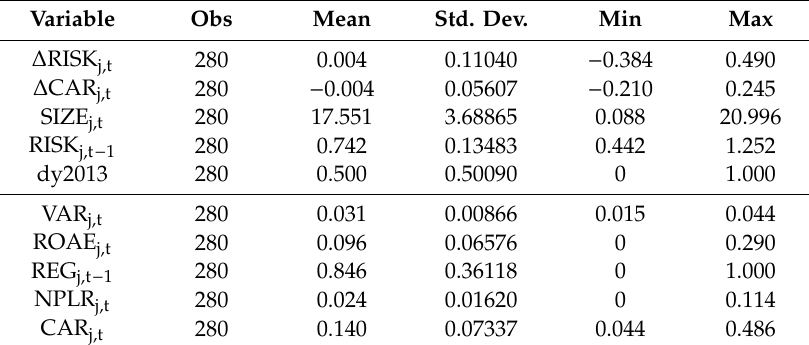
Table 1. Summary statistics of the dataset from 2009 to 2018.